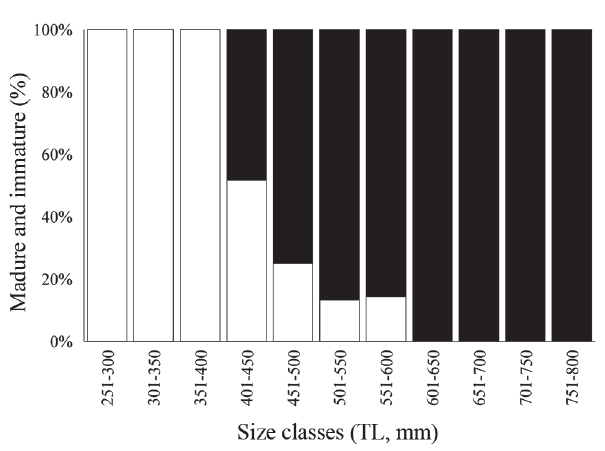
Fig. 7. Percentages of immature (white) and mature-resting females (black) per size classes (total length, mm) for Mycteroperca marginata individuals collected in the study area. n = 111.